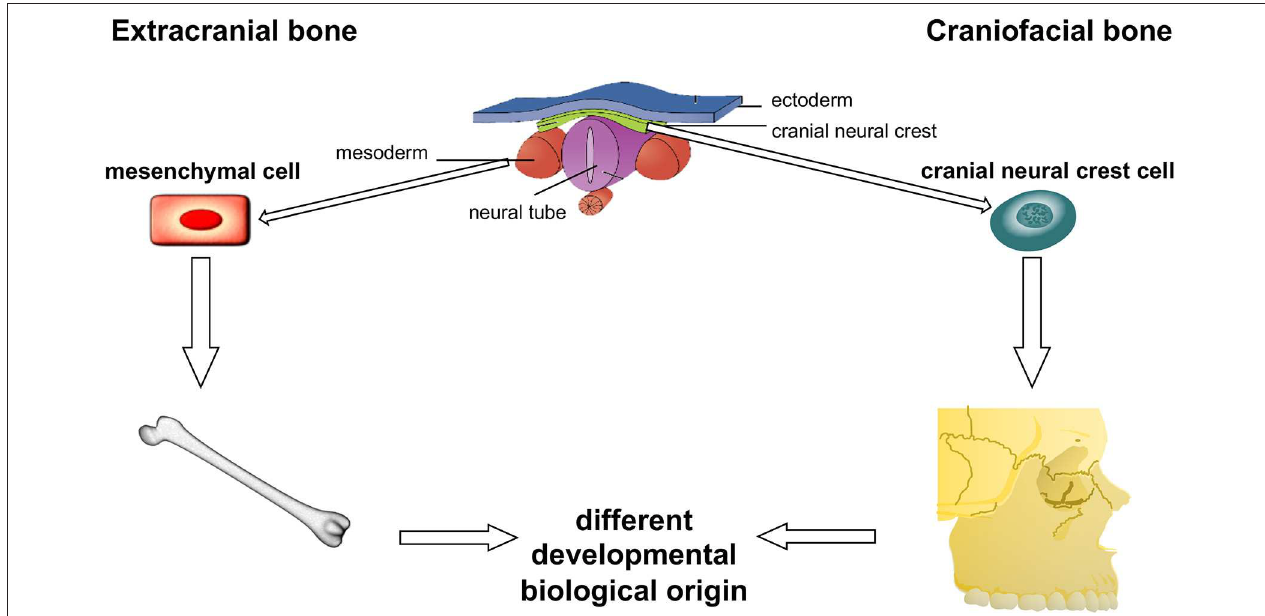
FIGURE 1 | Developmental biological origin of craniofacial and extracranial bone. The figure shows the different developmental biological origin of the craniofacial and extracranial bones. Extracranial bone is derived from the mesenchyme, whereas the craniofacial bone originates the cranial neural crest. The cranial neural crest is of ectodermal origin. (The figure was created adopting the neurulation scheme from Anatomy & Physiology, Connections: Web site. http://cnx.org/content/col11496/1. 6/, Jun 19, 2013 and using the software tool powerpathways, 2010; source: epath3d San Diego,